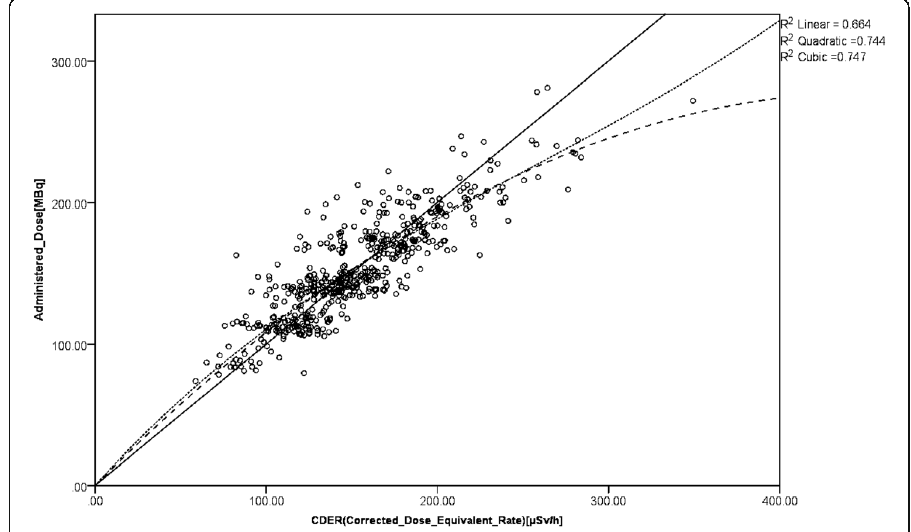
Fig. 3 Scatter plot with CDER and administered dosage. Solid line , linear; long dashed line , quadratic; short dashed line ,